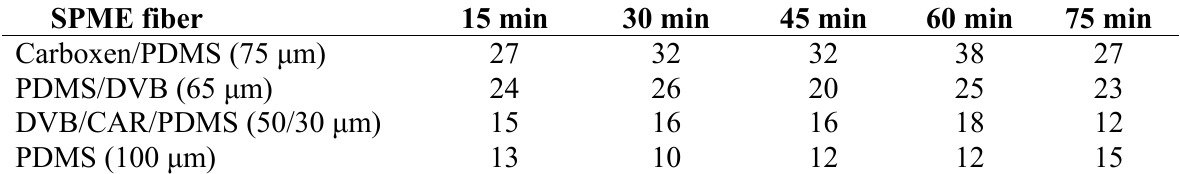
Table 1. The number of identified organic volatile flavor compounds in FST 1.